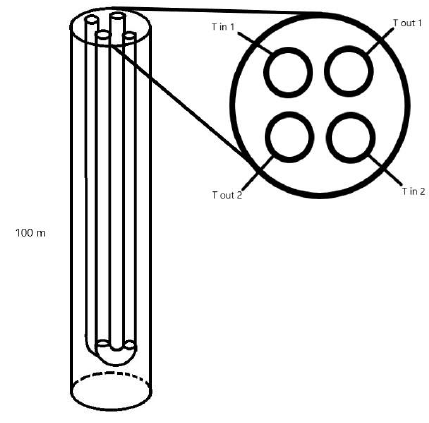
Table 1. Borehole heat exchanger (BHE) settings.